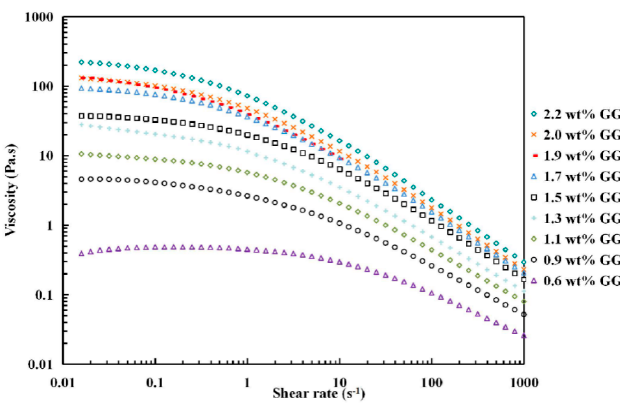
Figure 1. Apparent viscosity of GG solutions of different concentrations as a function of shear rate.